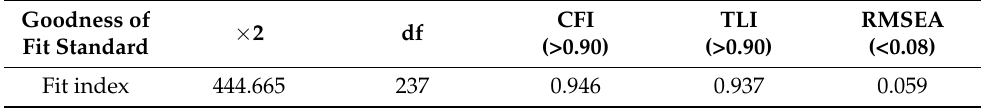
Table 4. The goodness of fit for the structural equation